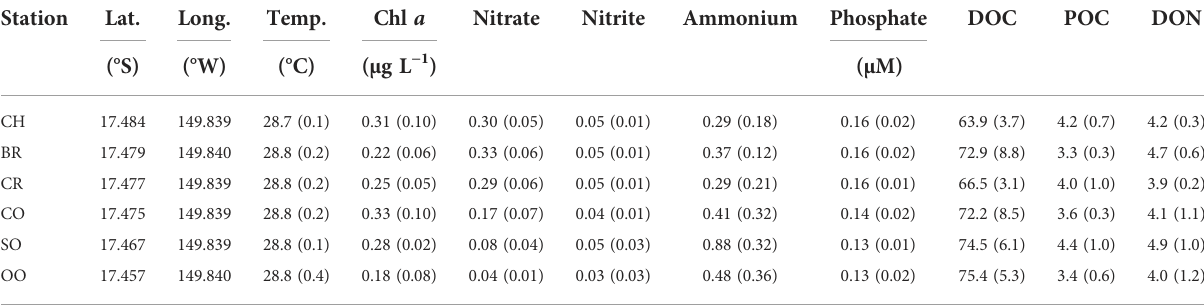
TABLE 1 Location of the sampling stations depicted in Figure 1 , and the average temperature and concentrations of Chl a , nitrate, nitrite, ammonium, phosphate, dissolved organic carbon (DOC), particulate organic carbon (POC) and dissolved organic nitrogen (DON) in seawater samples collected from repeated sampling at each station over a two-week